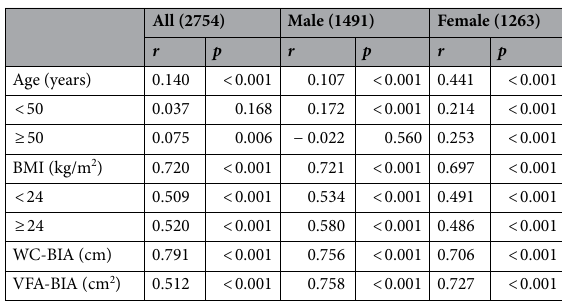
Table 5. Correlation of age, BMI, WC and VFA by BIA with VFA by CT